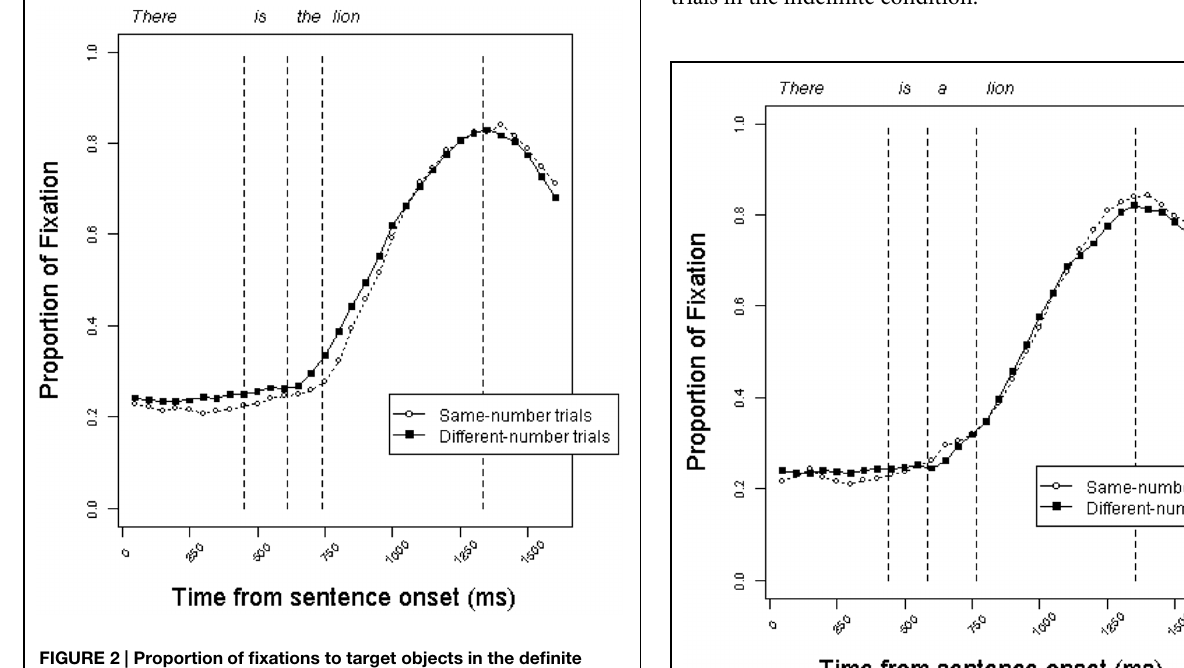
FIGURE 2 | Proportion of fixations to target objects in the definite condition on same-number versus different-number trials in Experiment 1. Fixation proportions are averaged within 50 ms bins. Dashed lines represent average onsets of each word type within trial type (same vs. different).